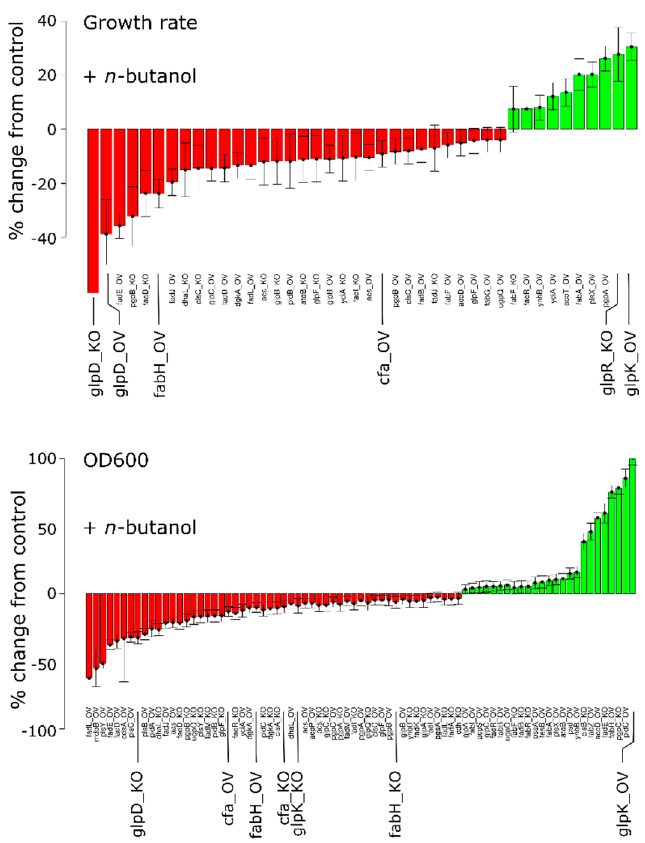
Figure 6. Specific growth rates and optical densities at steady state. Values of genetic constructs are compared to controls. Only data that were statistically significant ( p < 0.05) are shown. Genes discussed in the text are indicated by larger font